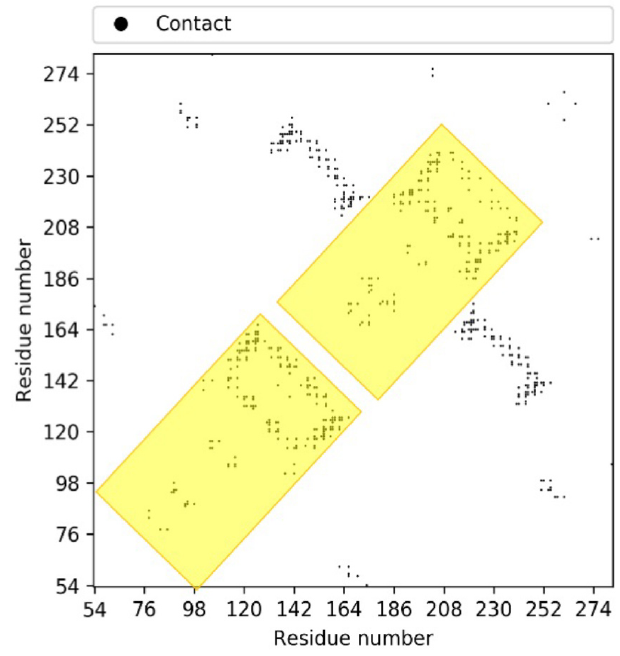
Figure 3. Tmem41b Contact map constructed using DeepMetaPSICOV and plotted using Conkit. The highlighted areas represent repeat units that have been revealed through evolutionary covariance analysis.